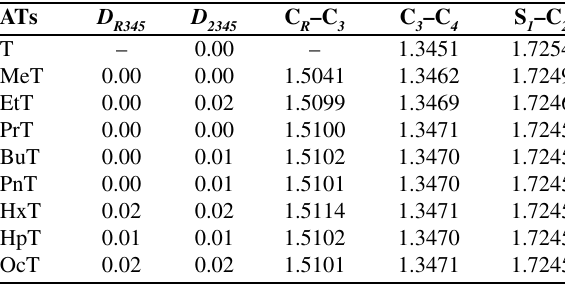
Table 1. Calculated torsion angles (in degree) and bond lengths (in angstrom) for studied species at HF/6-31G(d,p) level of theory.